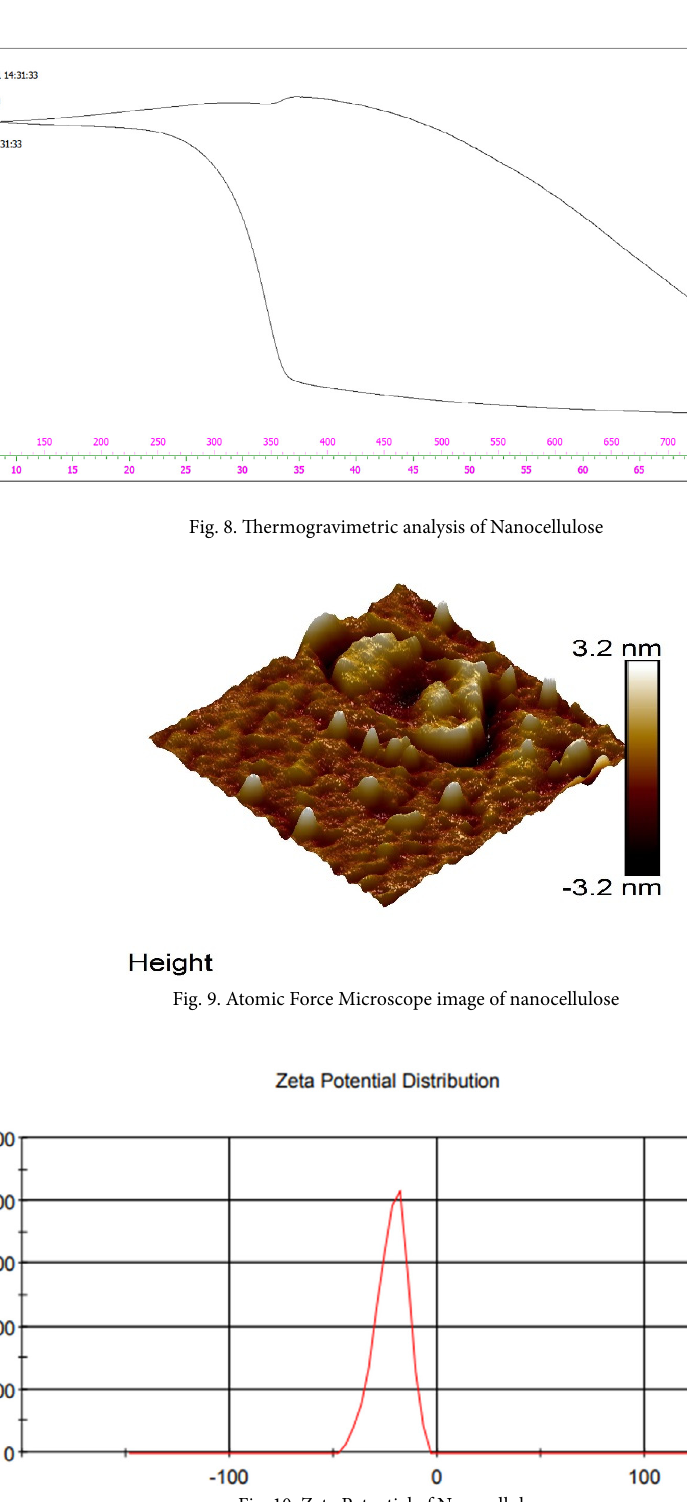
Fig. 10. Zeta Potential of